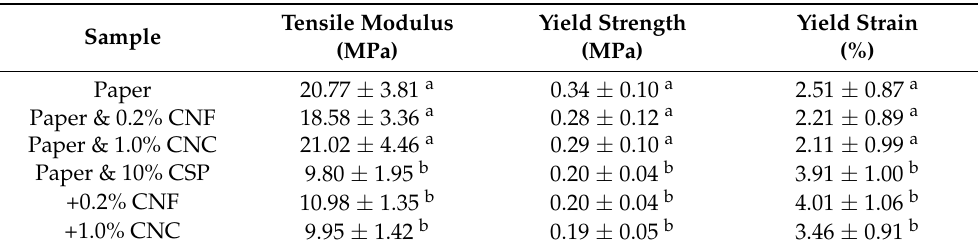
Table 4. Mechanical properties of paper impregnated with cottonseed protein and nanocellulose dispersions from wet strength